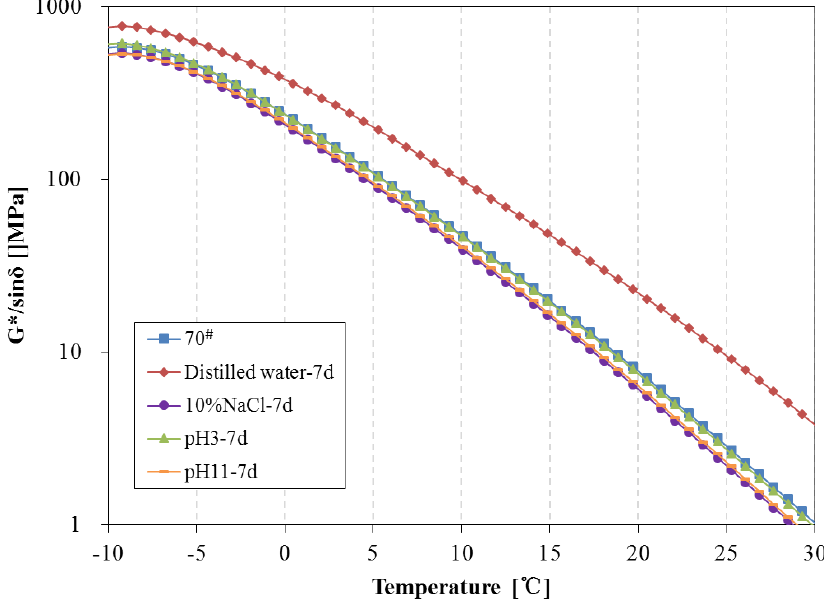
Figure 9. Rutting parameter of 70 # asphalt before and after 7 days immersion.